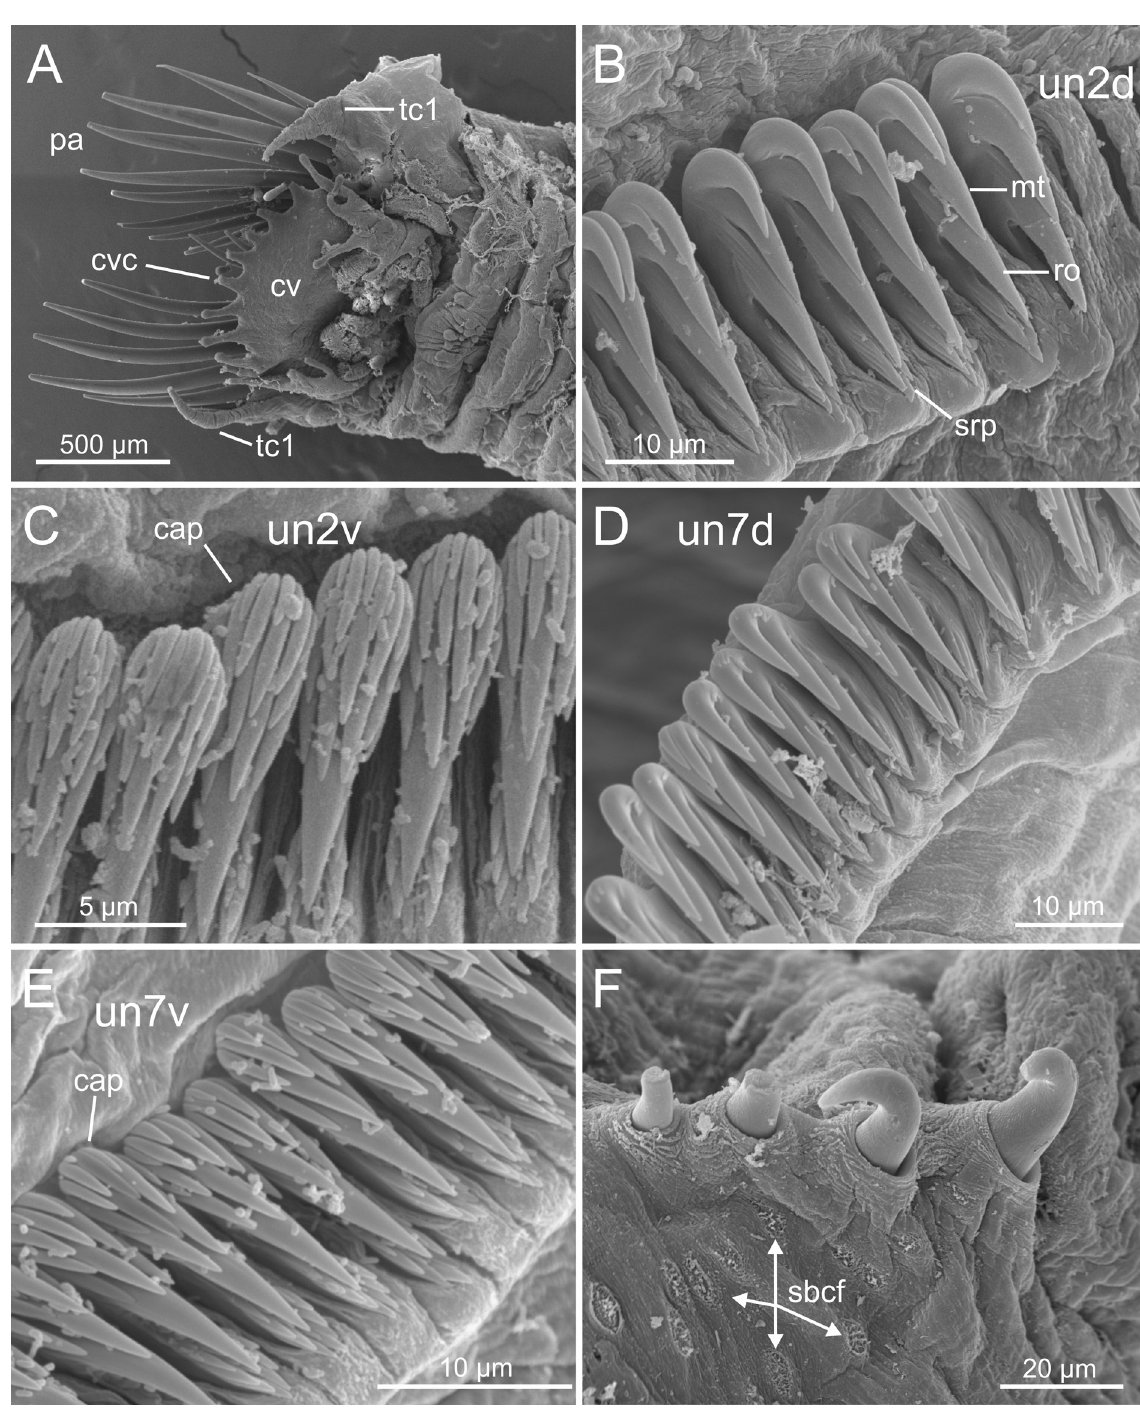
Fig. 14. Cistenides hyperborea Malmgren, 1866. SEM micrographs from two medium-sized specimens (BIOICE sample 2060, IINH-40471). A . Anterior end, ventral view. B–C . Unciniger 2, dorsal and ventral uncini, respectively. D–E . Unciniger 7, dorsal and ventral uncini, respectively. F . Scaphal hooks and scaphal basis ciliary